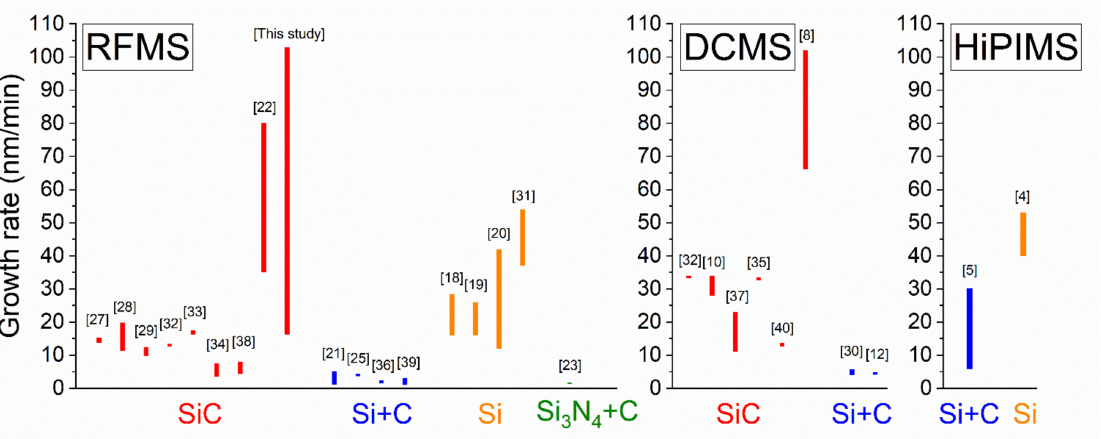
Figure 1. Growth rate dependence on MS mode and type of sputtered target. Hänninen T., et al., 2018 [4]; Pettersson M., et al., 2013 [5]; Kozak A.O., et al., 2017 [8]; Kulikovsky V., et al., 2014 [10]; Berlind T., et al., 2001 [12]; Bachar A., et al., 2018 [18]; Peng Y., et al., 2011 [19]; Saito N., et al., 1991 [20]; Li Q., et al., 2017 [21]; Sundaram K.B., et al., 2020 [22]; Li Q.et al., 2021 [23]; Hüger, E., et al., 2012 [25]; Peng Y., et al., 2018 [27]; Peng Y., et al., 2018 [28]; Peng Y., et al., 2014 [29]; Medeiros H.S., et al., 2011 [30]; Peng, Y., et al., 2010 [31]; Bhattacharyya A.S., et al., 2009 [32]; Bhattacharyya A.S., et